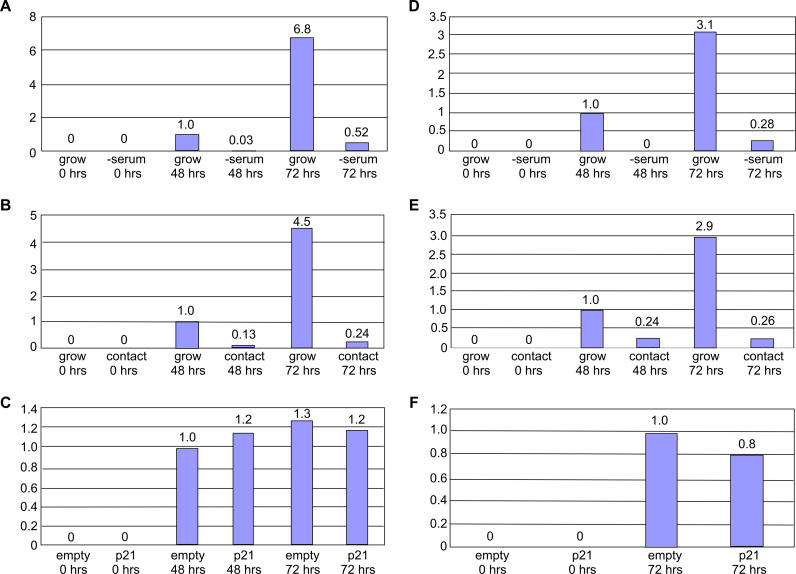
Quiescence, but Not Simply Cell-Cycle Arrest, Protects against DifferentiationHuman dermal fibroblasts 91-SF5 were transduced with a MyoD-estrogen receptor fusion, selected for stably transduced cells, and differentiated. At the indicated time points after differentiation, myogenin (A–C) and myosin heavy chain (D–F) expression levels were determined with real time RT-PCR using GAPDH as an internal standard and normalized values were plotted. Myogenesis marker expression induced by differentiation was inhibited in cells that were made quiescent for 4 d by serum withdrawal (A and D) or contact inhibition (B and E) as compared with growing cells. In contrast, in cells arrested by overexpression of the CKI p21, there was no reduction in myogenesis marker expression as compared with control cells transduced with an empty vector (C and F).